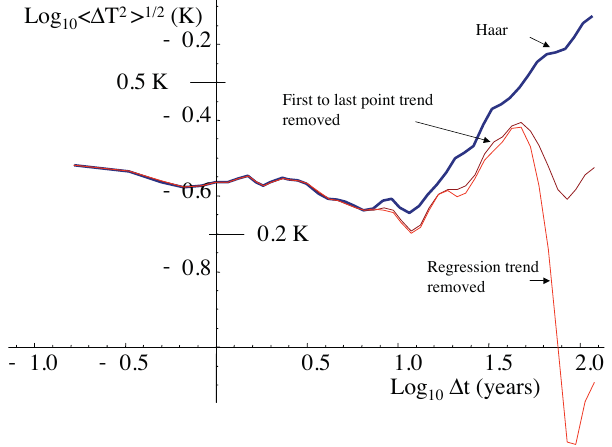
Fig. 12. The same temperature data as Fig. 10: a comparison of the RMS Haar structure function applied to the raw data, after removing linear trends in two ways. The first defines the linear trend by the first and last points, while the second uses a linear regression; all were multiplied by C hybrid = 10 0 . 35 =